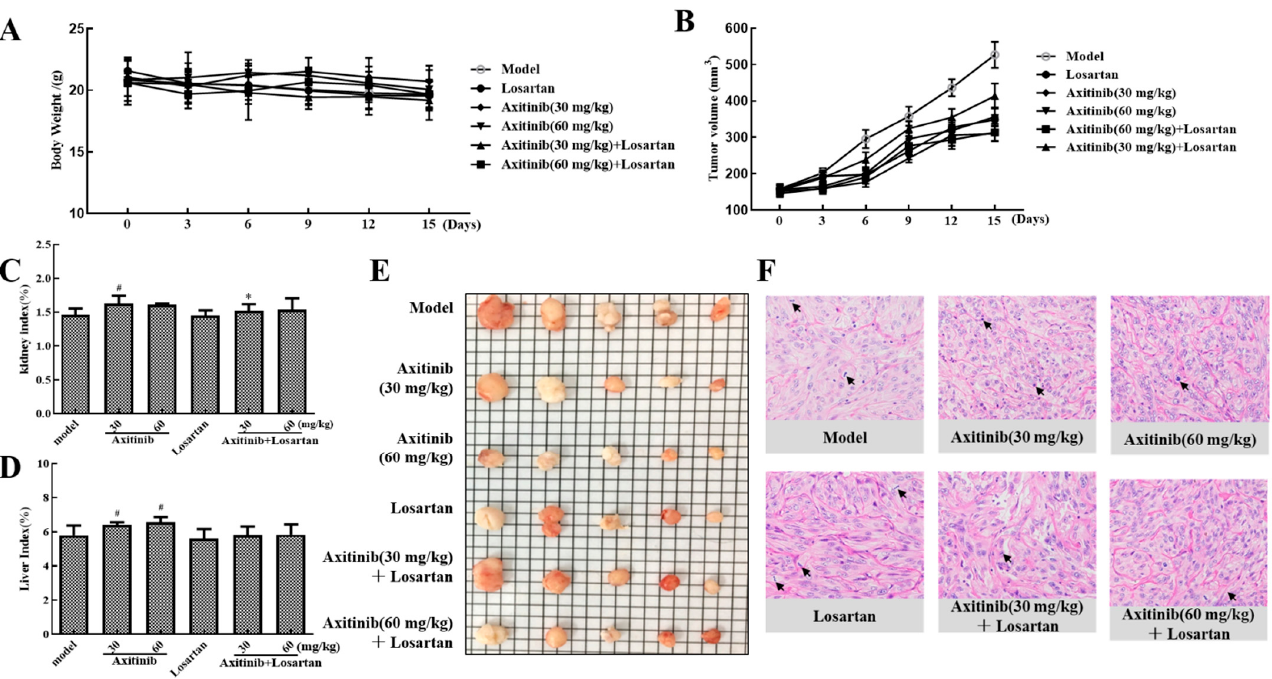
Figure 5. Effects of axitinib combined with losartan on xenograft tumor growth and organ index. ( A ) 15 days’ administration of axitinib combined with losartan on the body weight of mice. ( B ) 15 days’ administration of axitinib combined with losartan on the growth of xenograft tumor. ( C ) Effects of axitinib combined with losartan on kidney index of tumor-bearing mice. ( D ) Effects of axitinib combined with losartan on liver index of tumor-bearing mice. ( E ) Tumor pieces of each group after drug treatment. ( F ) Effects of axitinib combined with losartan on the histological changes of xenograft tumor. # p < 0.05 vs. model, * p < 0.05 vs. axitinib group.